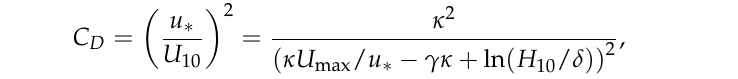
u was calculated from the ob- * , max